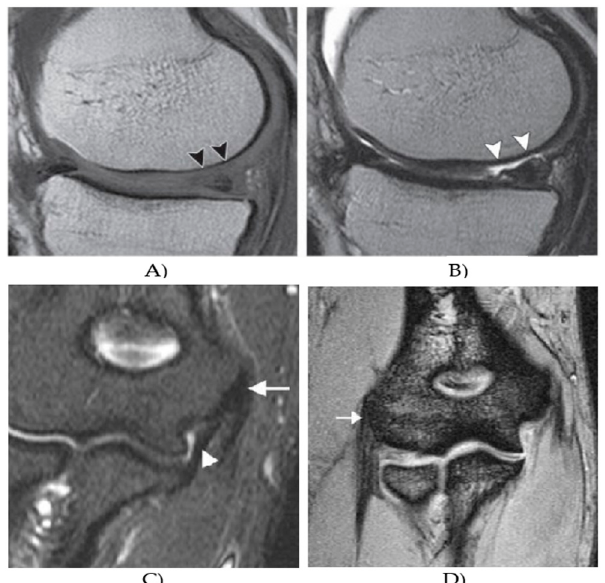
Figure 1. Example from MR datasets: ( A ) T1 weighted image, showing a weak contrast between the cartilage surface and synovial fluid, ( B ) proton density-weighted image, ( C ) coronal fat-saturated proton density-weighted image of elbow muscle, showing a low signal intensity of the common flexor tendon, which is located at the medial epicondyle (arrow), and ( D ) coronal gradient echo image of elbow muscle, showing a normal manifestation of a normal extensor tendon at the lateral epicondyle (arrow).